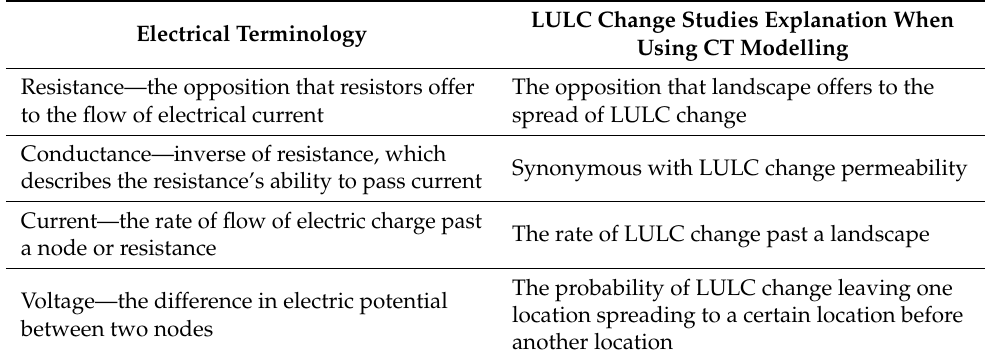
Table 2. LULC change spread explanation of electrical terminology.